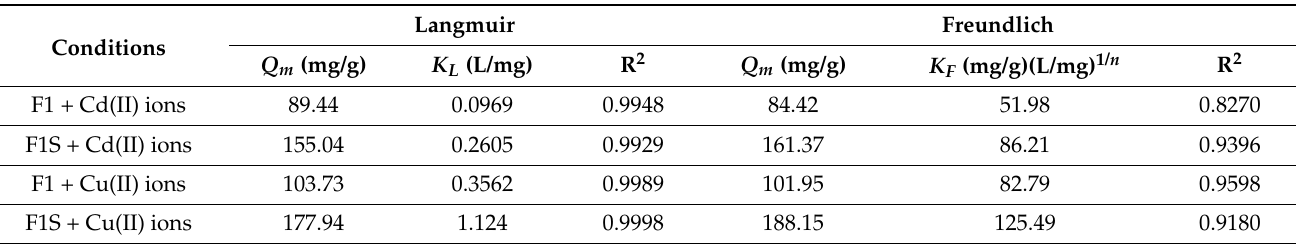
Table 5. The calculated constants of the Langmuir and Freundlich equilibrium isotherms for the removal of cadmium and copper ions using the F1 and F1S samples.